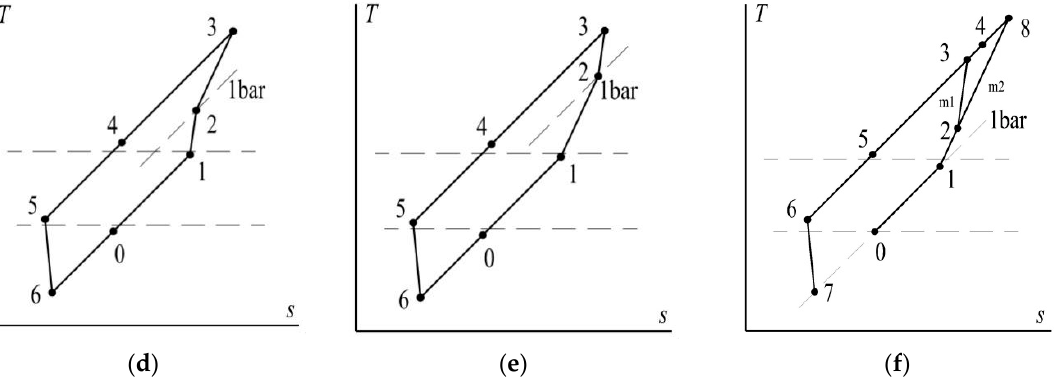
Figure 2. T-s diagram of different air-reversed Brayton heat pump systems with a turbocharger. ( a ) Cycle A; ( b ) Cycle B; ( c ) Cycle C; ( d ) Cycle D; ( e ) Cycle E; ( f ) Cycle F.